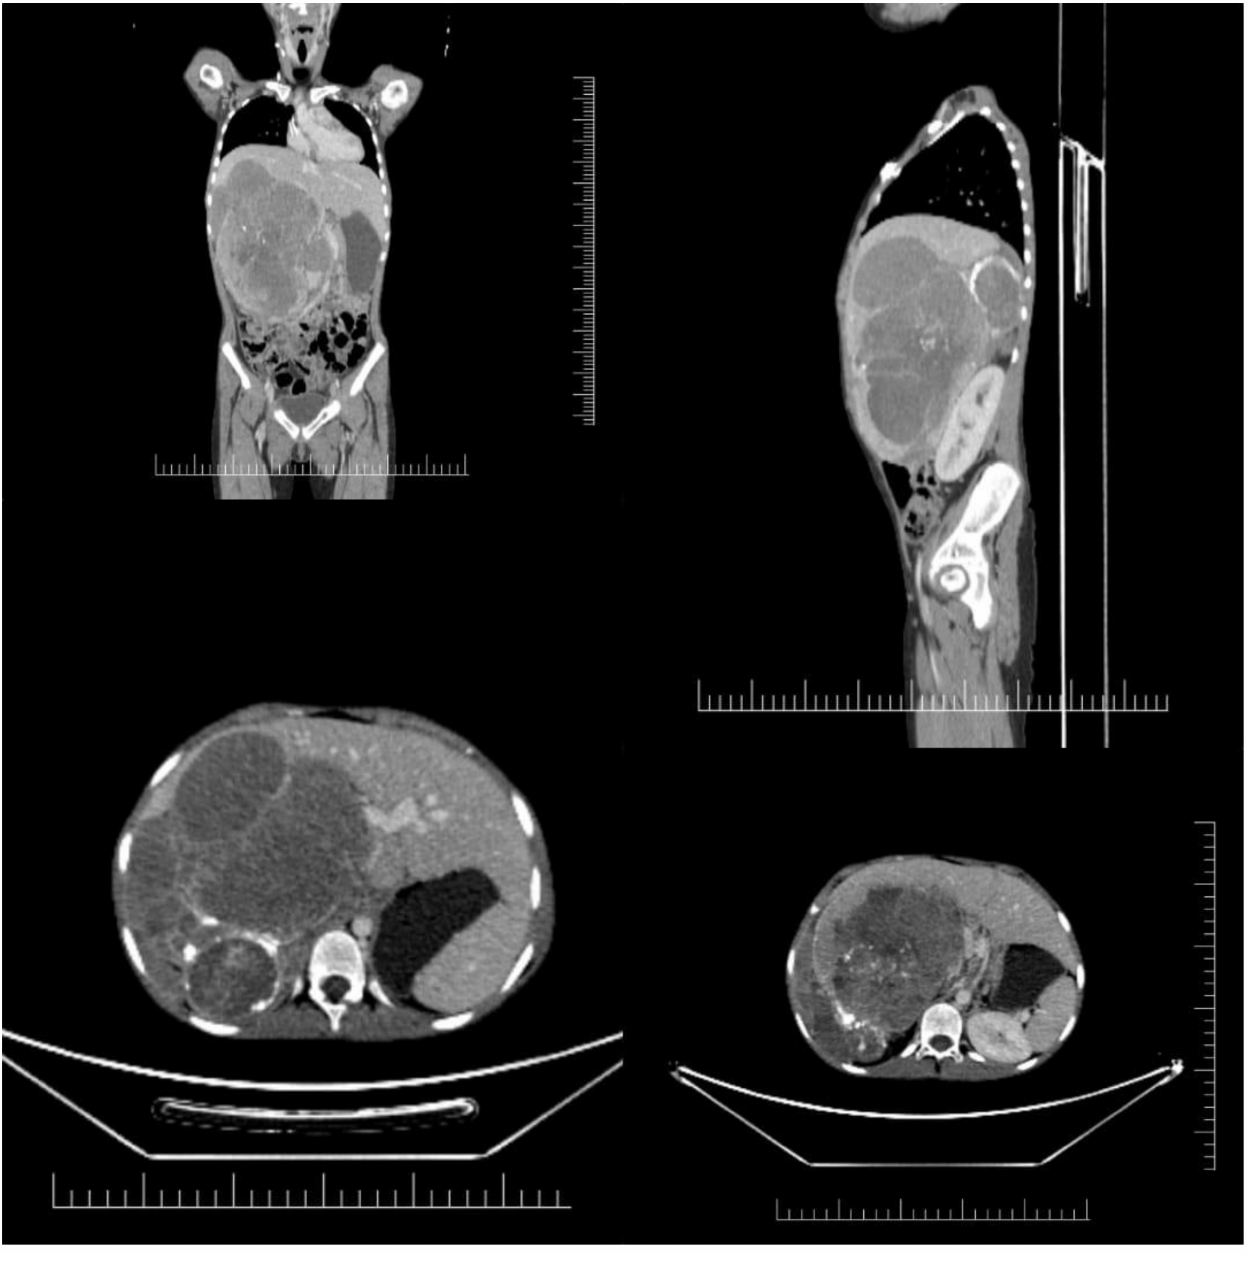
Figure 1. CT scan showing a bulky abdominal neuroblastoma with liver invasion and encasement of abdominal aorta and inferior vena